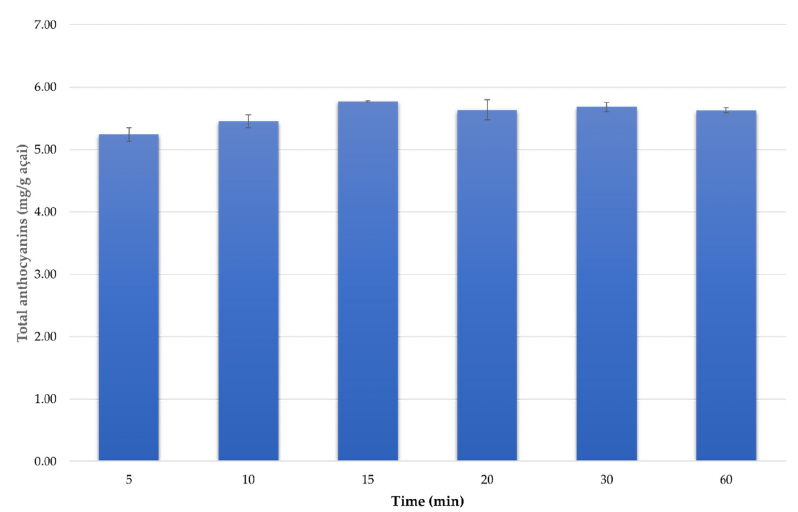
Figure 4. Total anthocyanin concentrations (mg/g açai) according to extraction times ( n = 12).